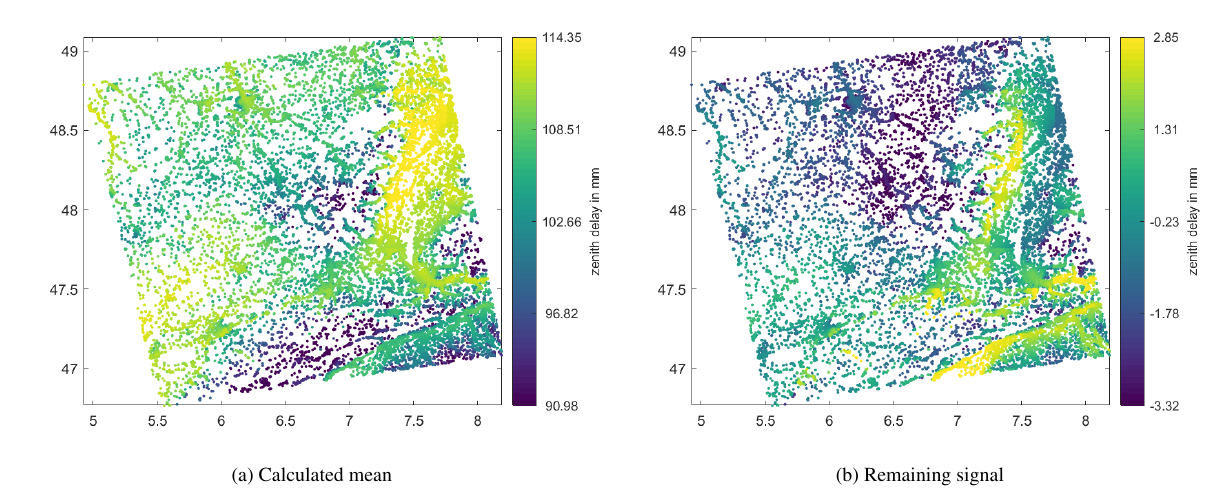
Figure 2. Calculated mean for the stack from ERA5 data and the remaining difference after subtracting the height dependent